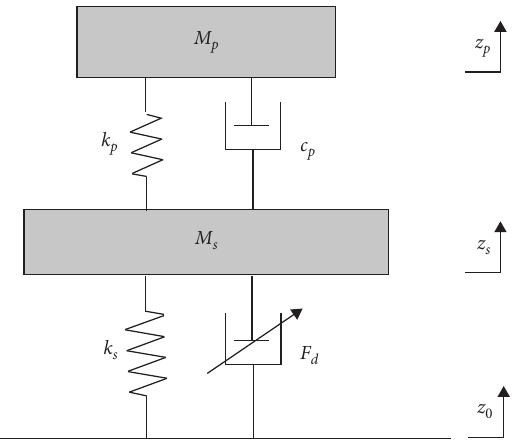
Figure 19: Semiactive seat suspension system model. Table 5: Parameter meaning of seat